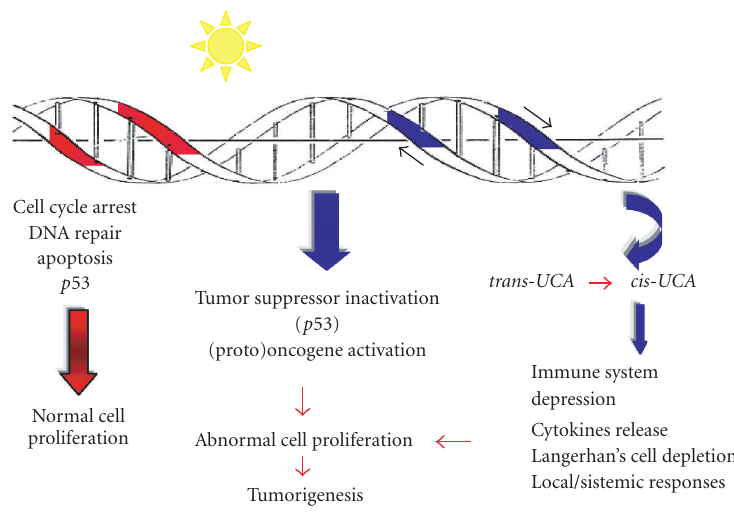
Figure 1: Molecular events following UV